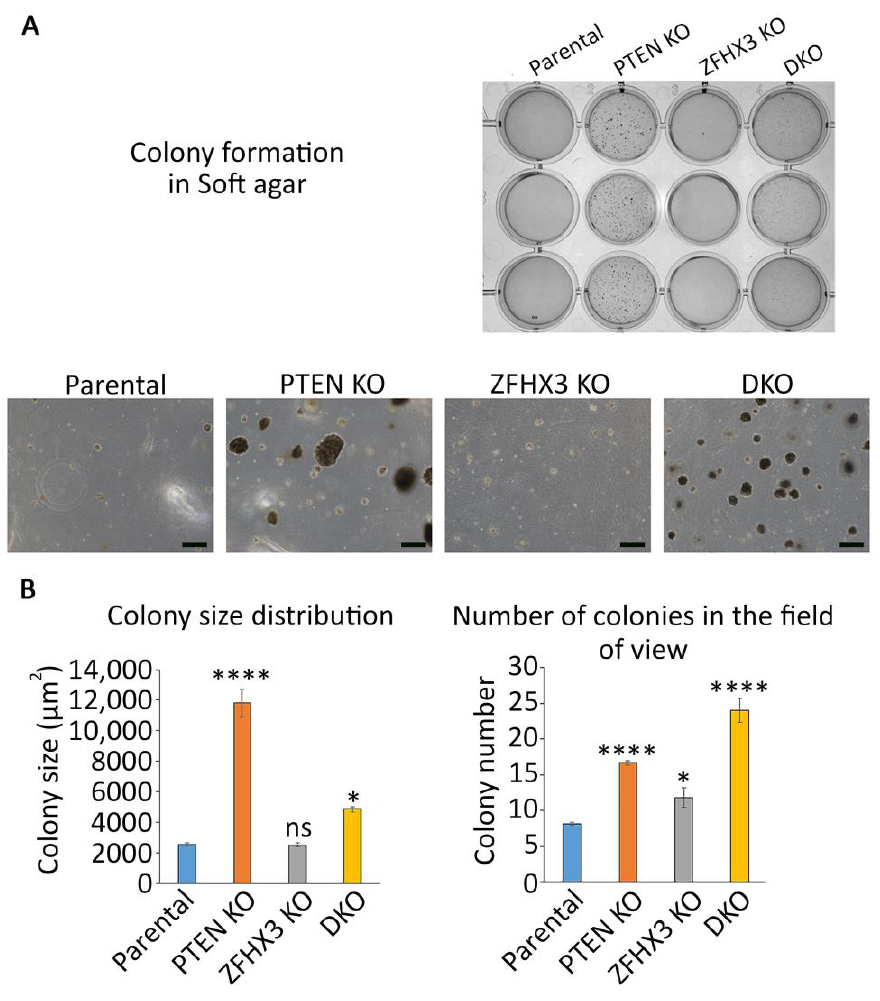
Figure 2. Anchorage independent growth of the gene-edited MCF10A cell lines in soft agar. ( A ) Overall view. Scale bars 200 μm. ( B ) Quantification of size (measured as apparent area) and numbers of colonies. N = 3, ANOVA, * p < 0.05, **** p < 0.0001 and ns: not significant.